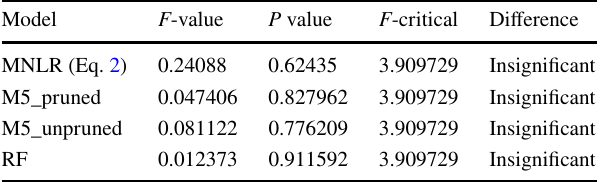
Table 5 Result of ANOVA single-factor test